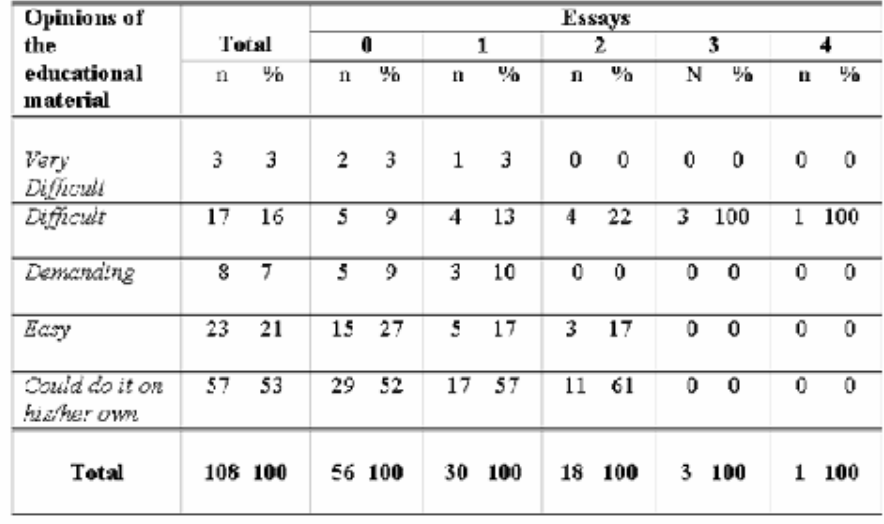
Table 9. Opinions of students who dropped out regarding the educational material by number of essays